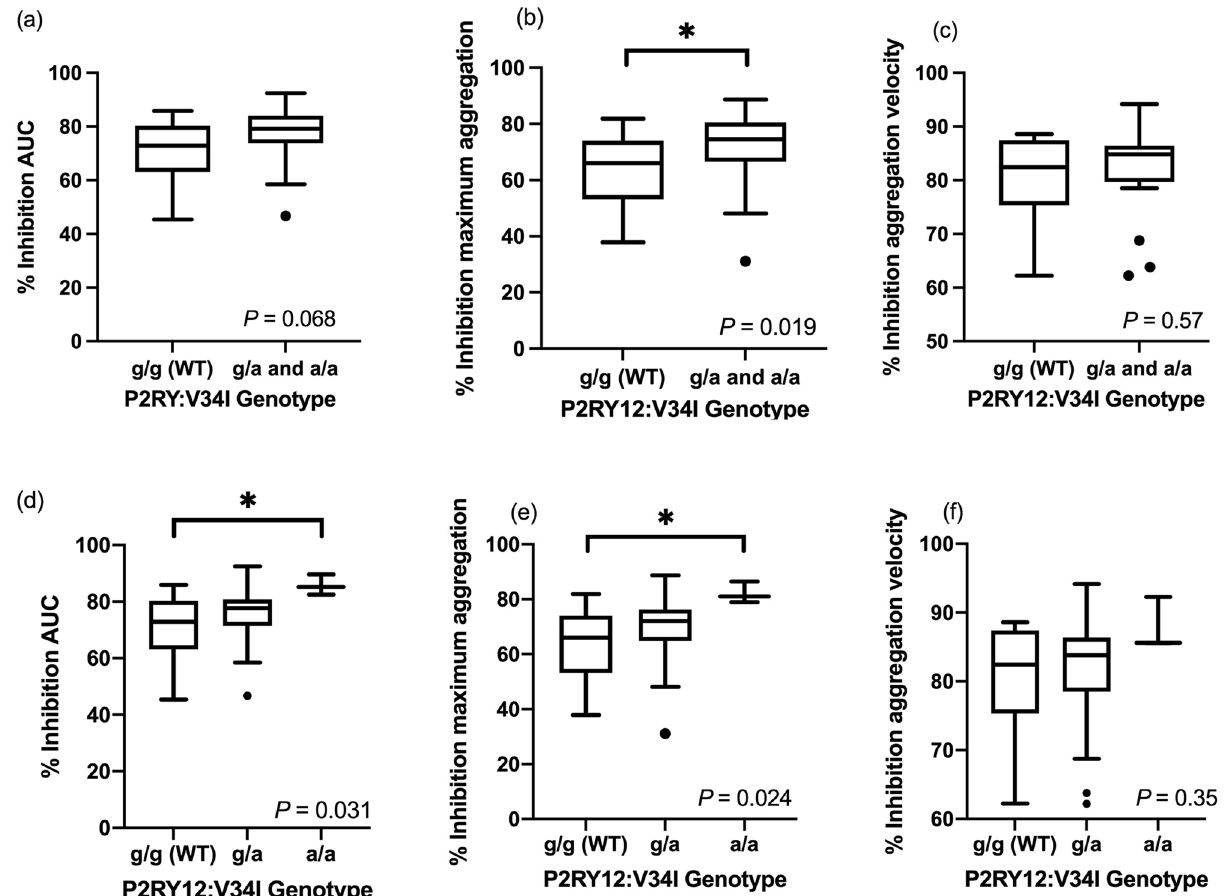
Figure 5. The percent inhibition of ( a ) area under the curve (AUC), ( b ) maximum aggregation (AU), and ( c ) aggregation velocity, measured by whole blood aggregometry, in cats with P2RY12:V34I wildtype (WT) (g/g) and variant genotype (both g/a and a/a genotypes). The percent inhibitions of ( d ) AUC, (e) AU, and ( f ) aggregation velocity were further divided into wildtype (g/g), heterozygous (g/a), and homozygous (a/a) genotypes. The horizontal line represents the median, the box the 25th and 75th percentile, the whiskers the 1.5 times interquartile range, and the points outside the whiskers are